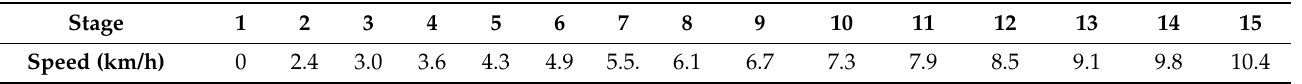
Table 1. The stage number and corresponding speed of movement for the track and treadmill